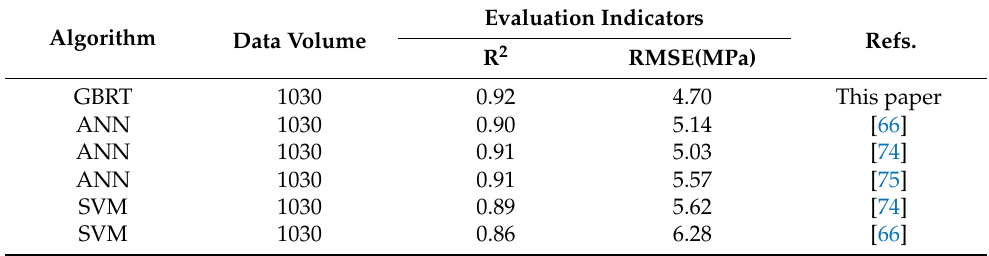
Table 7. Comparison with individual machine-learning algorithms with the same